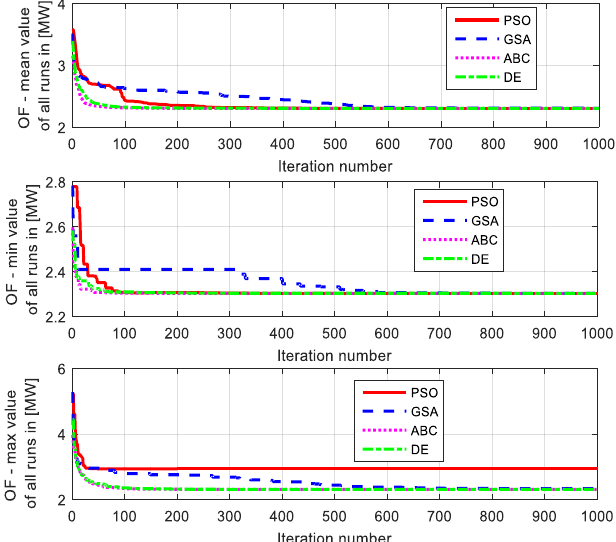
Figure 4. OF convergence—Max, Min, and Mean of all runs for the IEEE 9 test